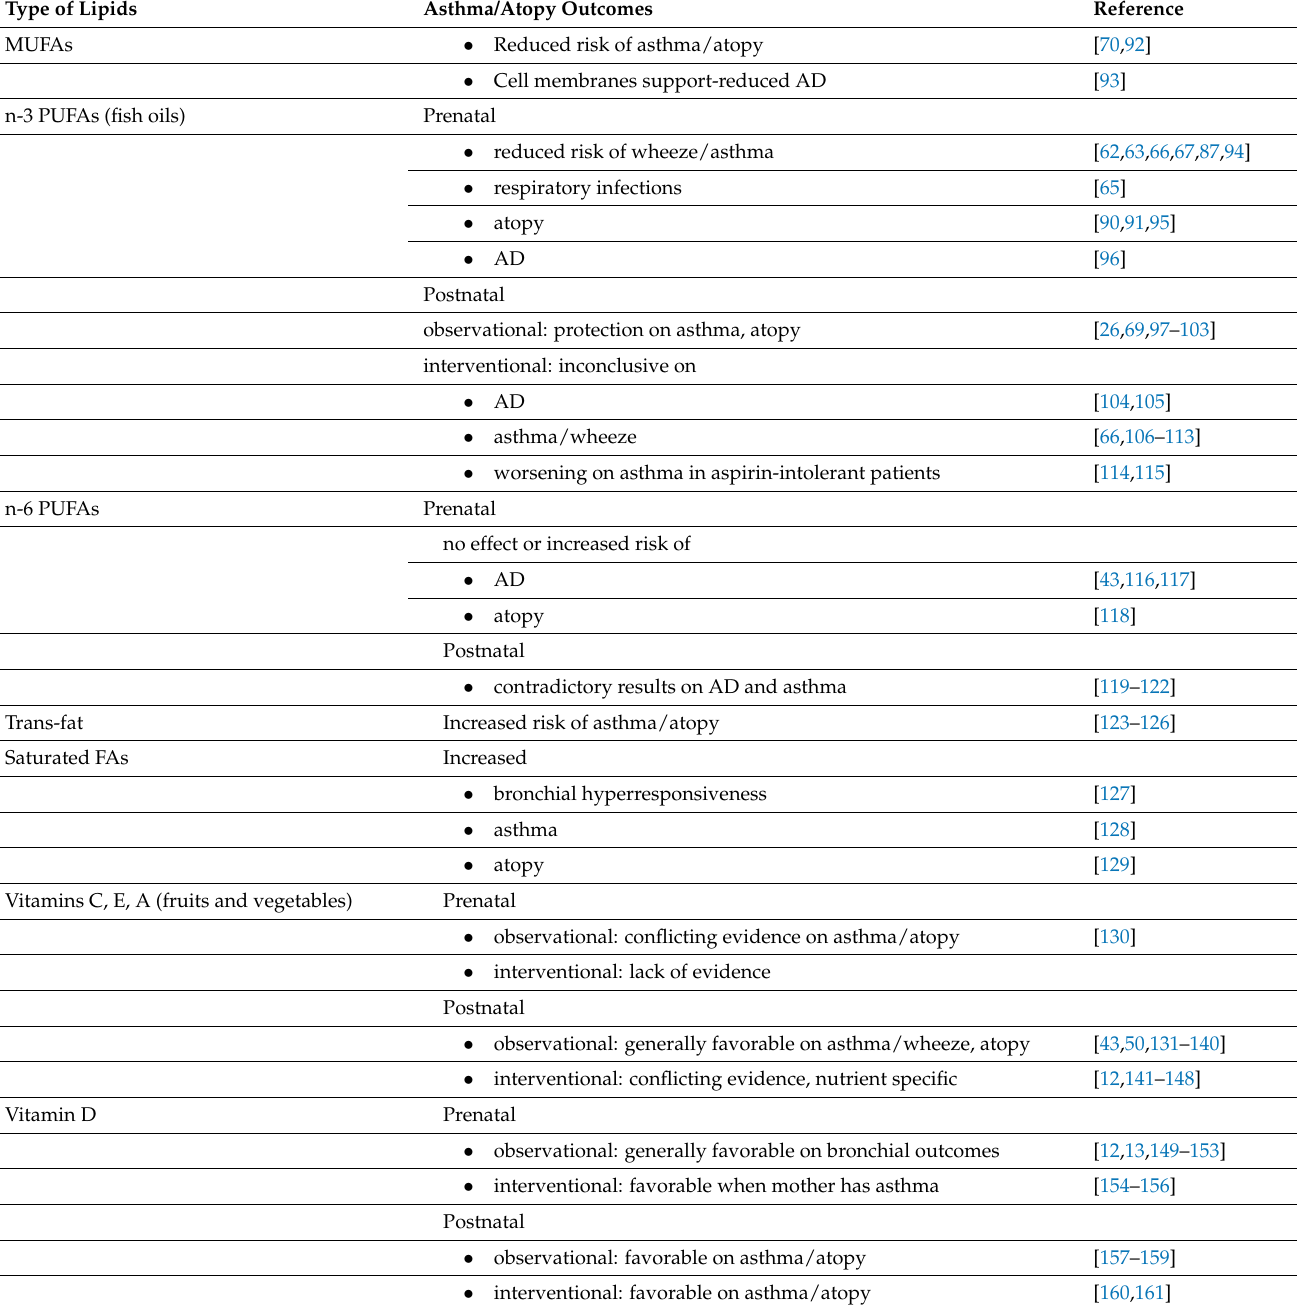
Table 1. Synopsis of the effect of monounsaturated fatty acids (MUFAs) and n3 polyunsaturated fatty acids (PUFAs), and vitamins A, C and E on asthma and atopy outcomes, and the effect of Vitamin D on bronchial and atopy